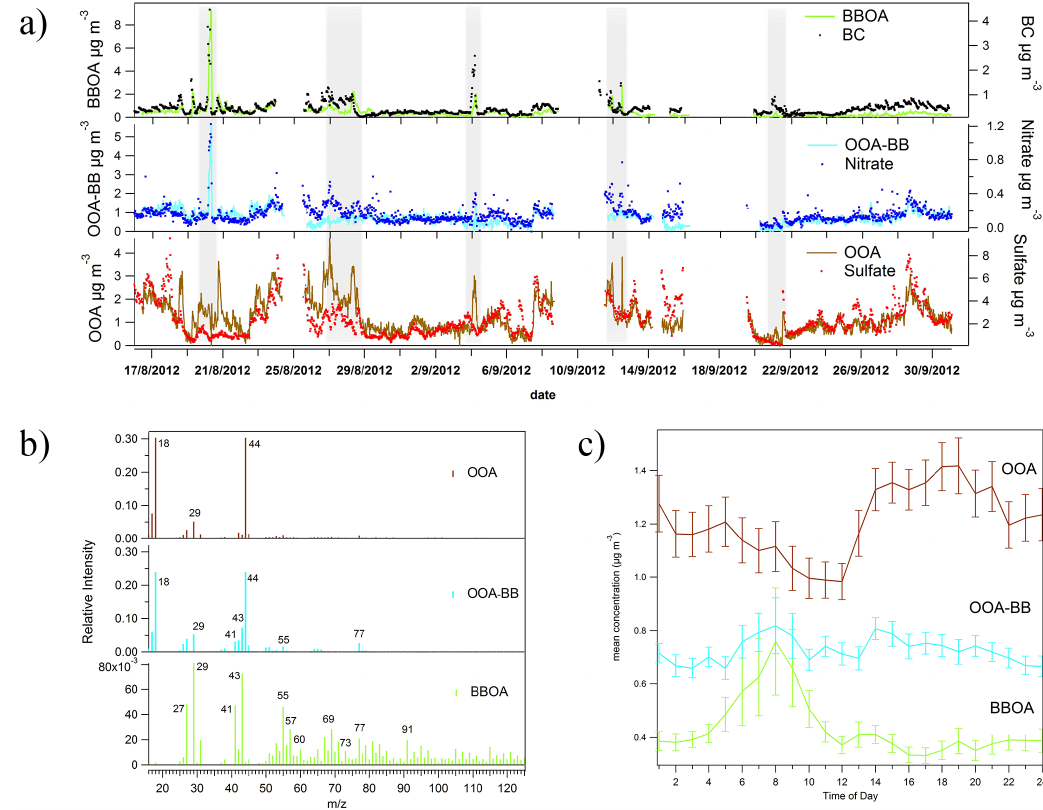
Fig. 5. (a) Time series for the components contributing to OA mass loadings at Finokalia during the measurement period as identified by PMF analysis. For comparison, time traces of BC, nitrate and sulfate are shown. The extracted mass spectra for each factor are shown below the time series (b) , along with the diurnal profile of each factor (c) . Error bars in the diurnal profiles represent the standard deviation of diurnal